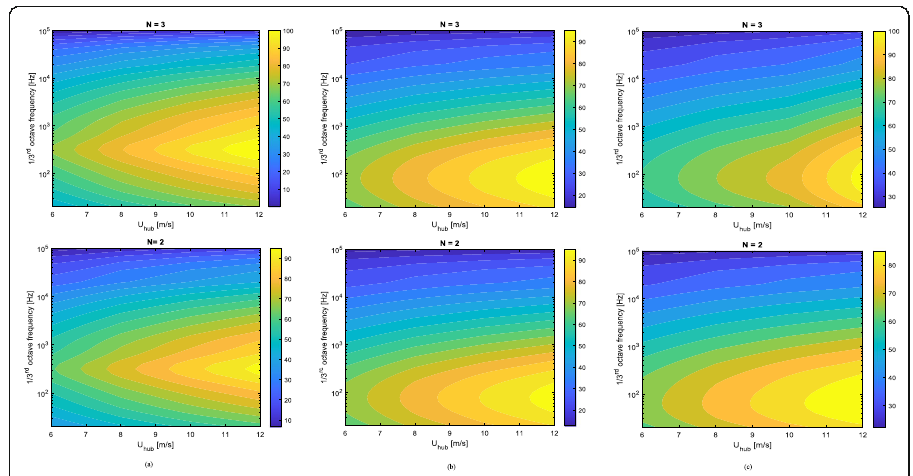
Fig. 8 Contour plot of Lw [dB] for three blade and two blade rotor using ( a ) BPM ( b ) Lowson ( c ) Grosveld trailing edge noise methods